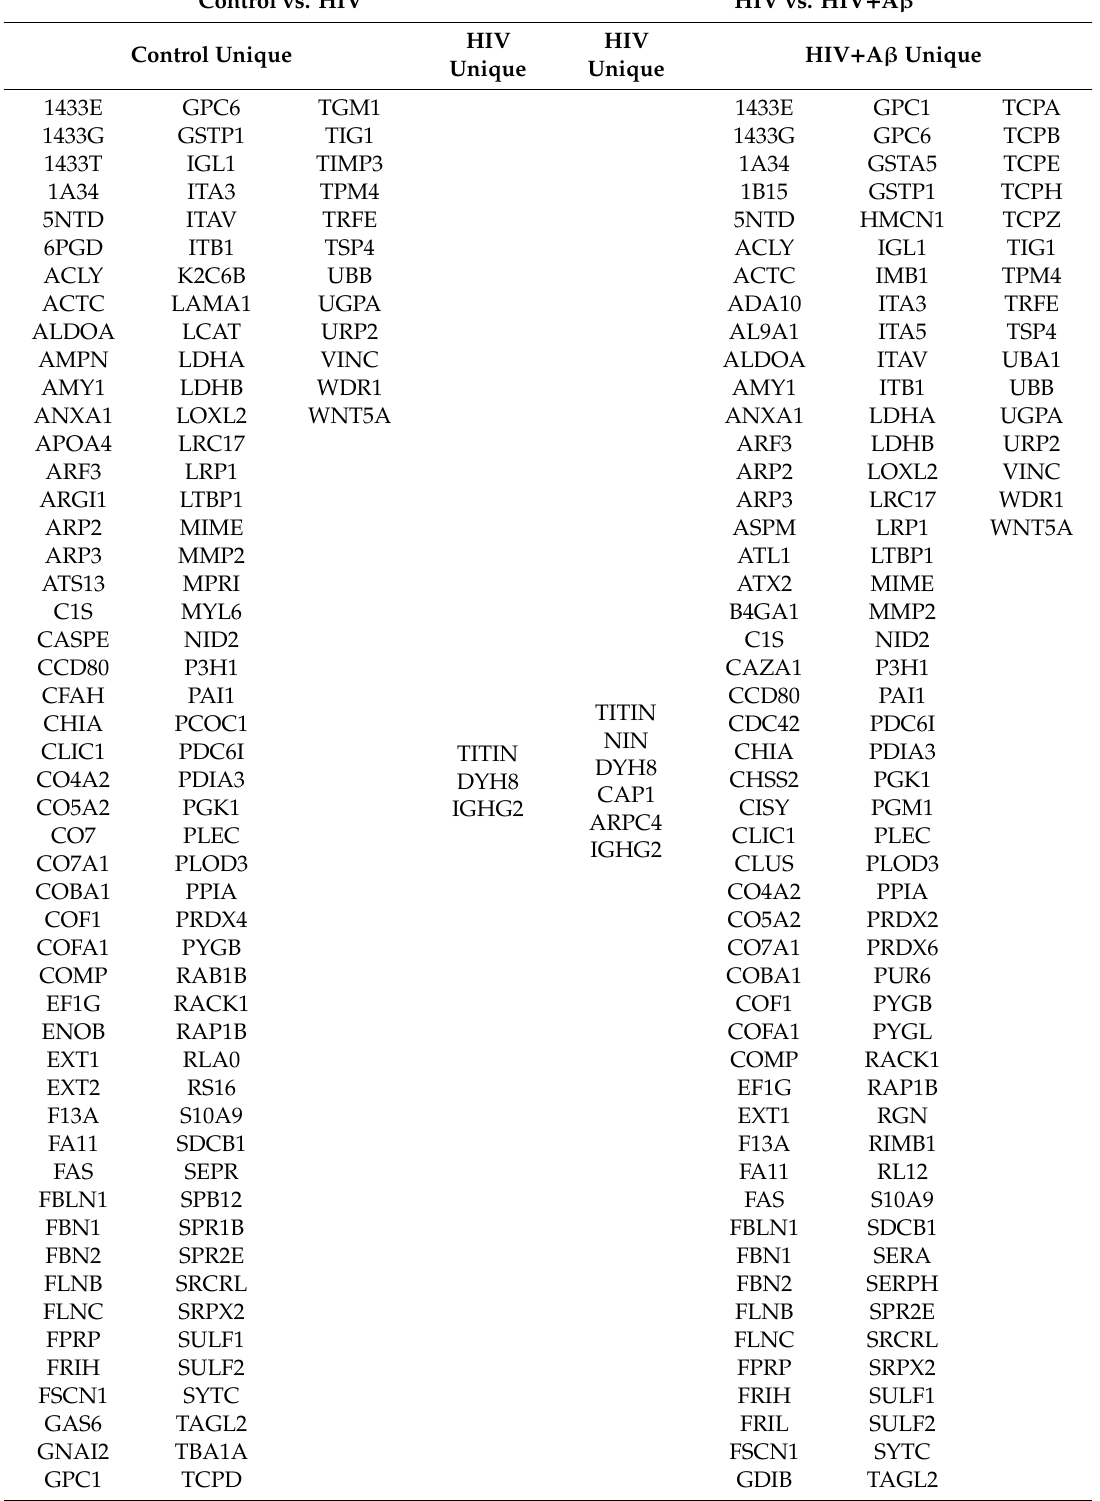
Table 2. List of the unique proteins in the EV surface proteome. Control vs.